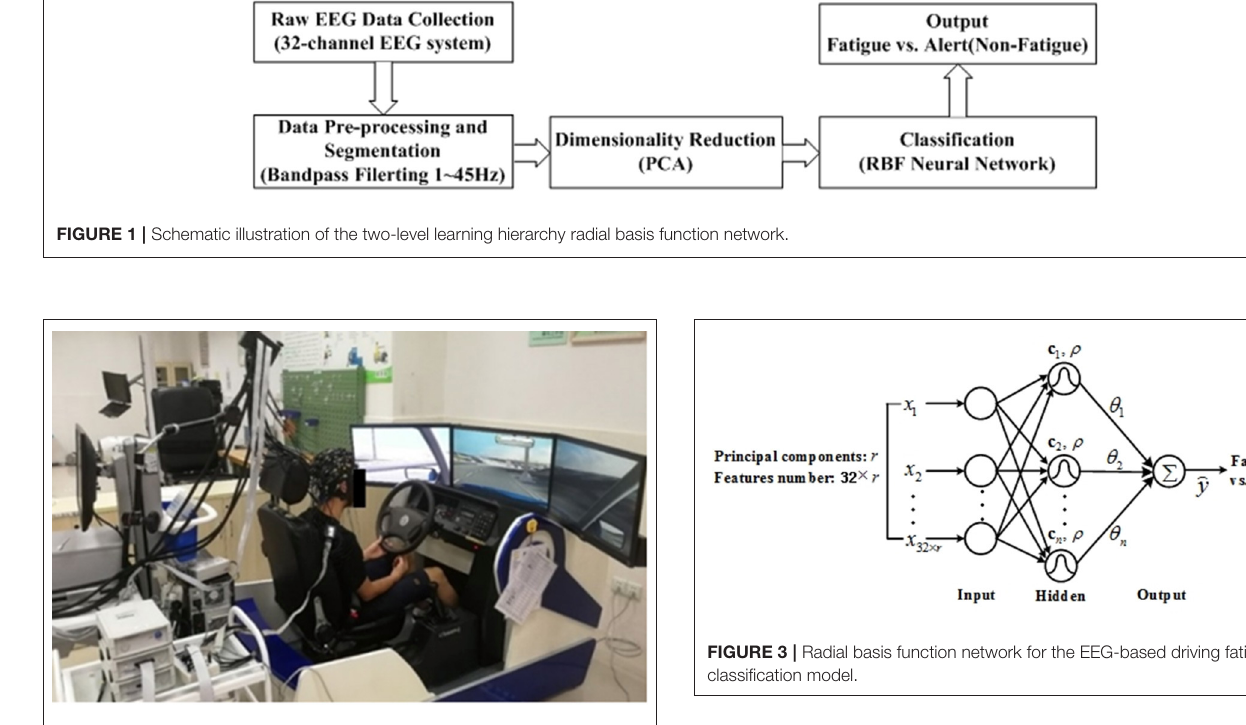
FIGURE 2 | The driving simulation system and EEG acquisition device.